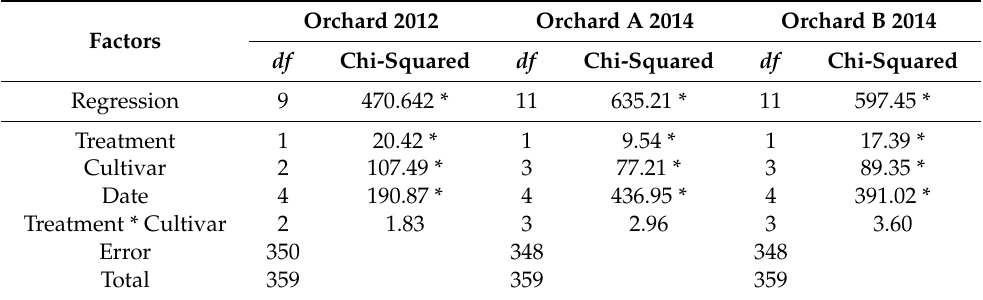
Table 2. Results of the binary logistic regression, separately performed for each year and orchard, on the infestation data and e ff ect of the di ff erent factors considered (asterisks indicate significant factors within each year, * p < 0.01). All of the goodness-of-fit tests of the reported models were found to be non-significant.